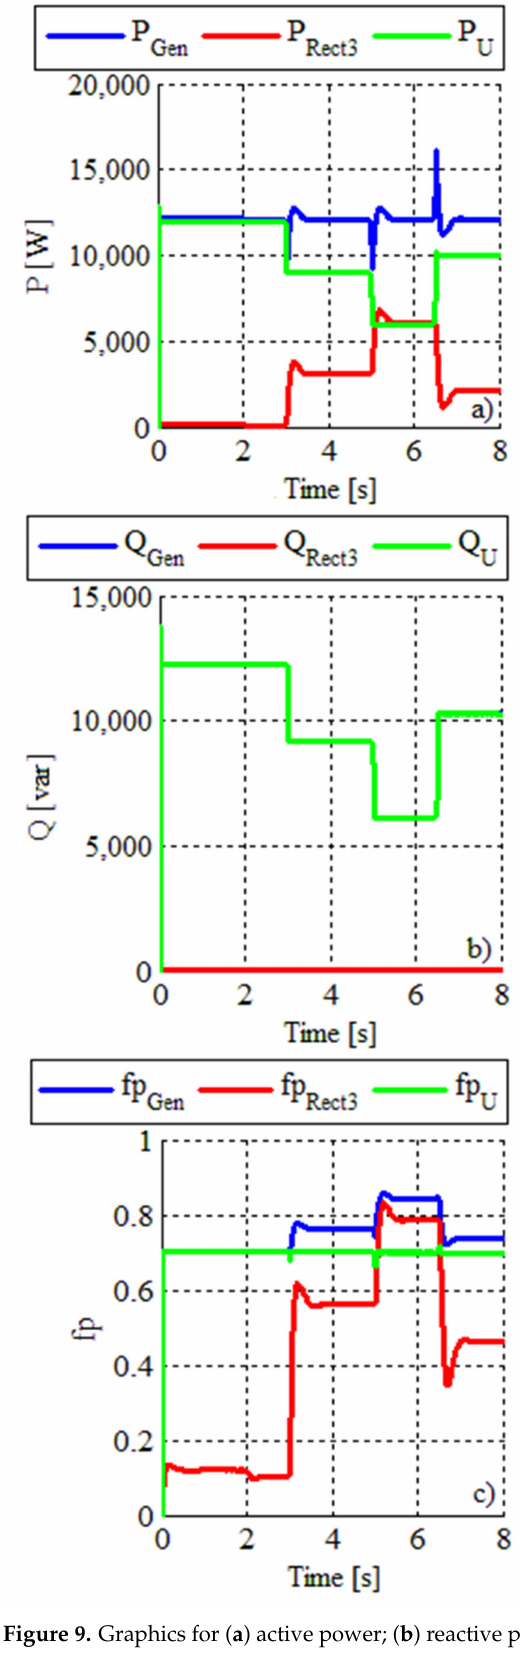
Figure 9. Graphics for ( a ) active power; ( b ) reactive power; and ( c ) the power factor with three-phase rectifier and symmetrical